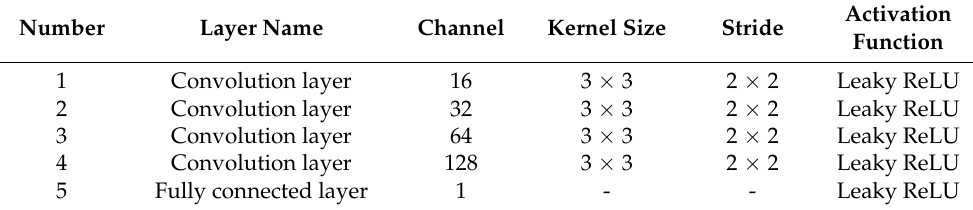
Table 2. Structure of discriminative model.